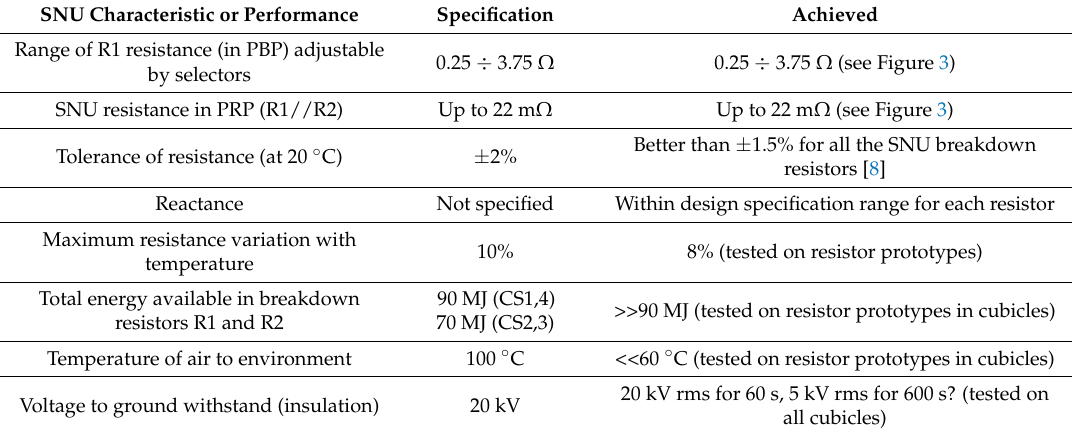
Table 2. Characteristic or performance of the CS SNU breakdown resistors (R1 and R2